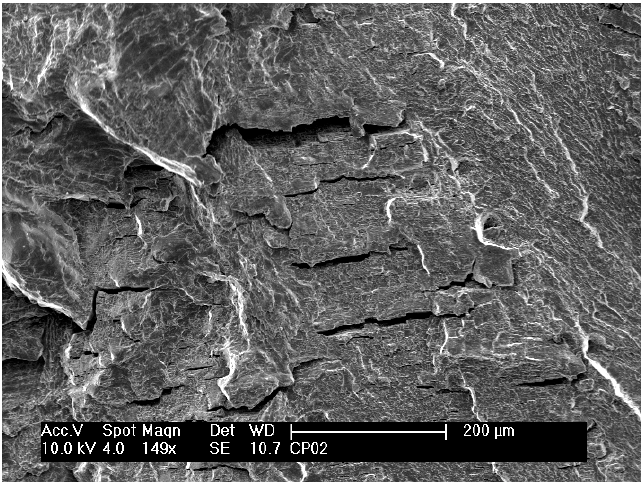
Figure 7. Scanning electron micrograph of the fracture surface of non-nitrided specimen after a fatigue test at 610 MPa and 6700 cycles to failure.